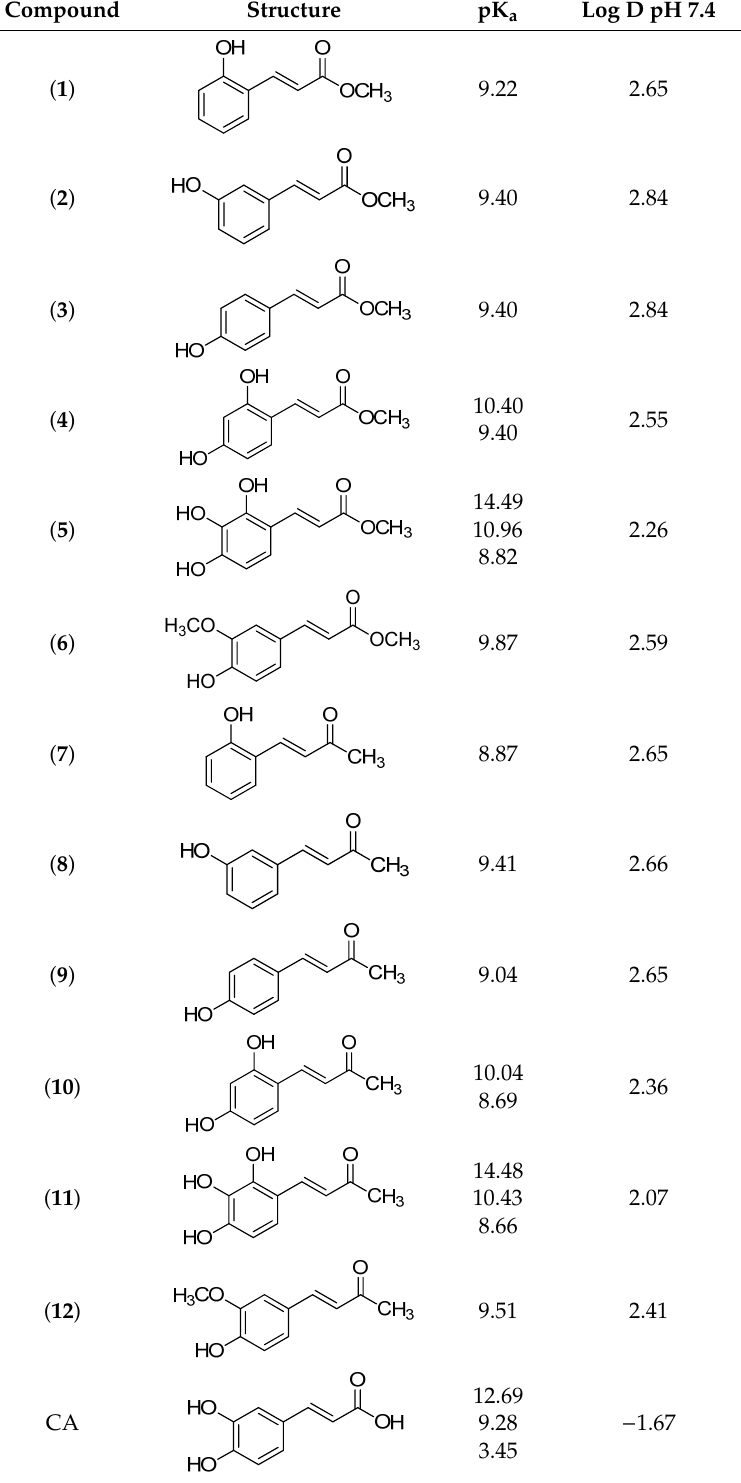
Table 1. List of tested compounds, their chemical structures, pK a and Log D values. Compound